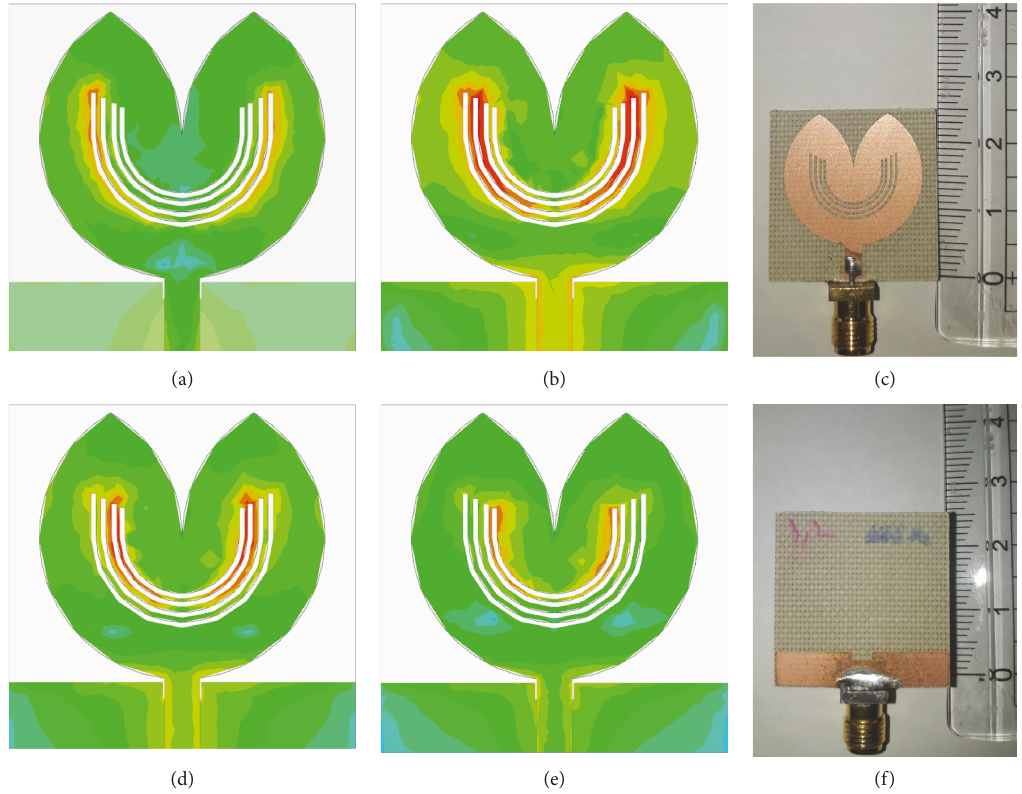
Figure 8: Simulated surface current distribution on the radiating patch of the proposed antenna at the corresponding central frequency of the notched band at (a) 3.57GHz, (b) 4.03GHz, (d) 4.68GHz, and (e) 5.32GHz. Prototype of the fabricated antenna. (c) Front view. (f) Back Table 3: Comparison of the proposed antenna with other reported references.